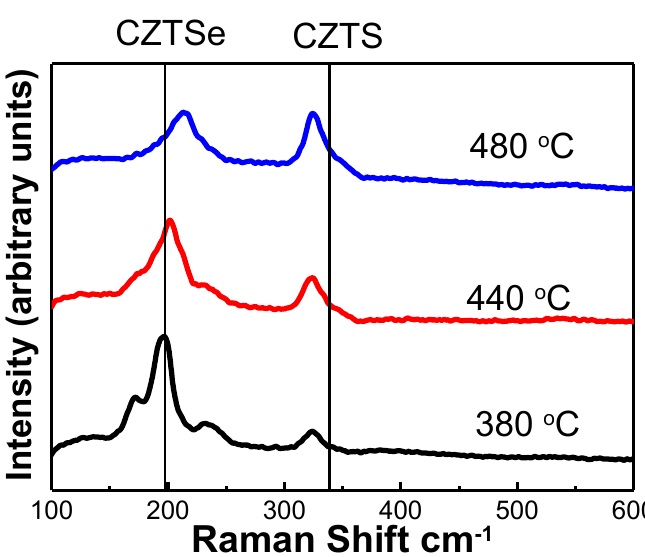
Figure 4. Raman spectra of the CZTSe films prepared at various growth temperatures ranging from 380 to 480 °C.